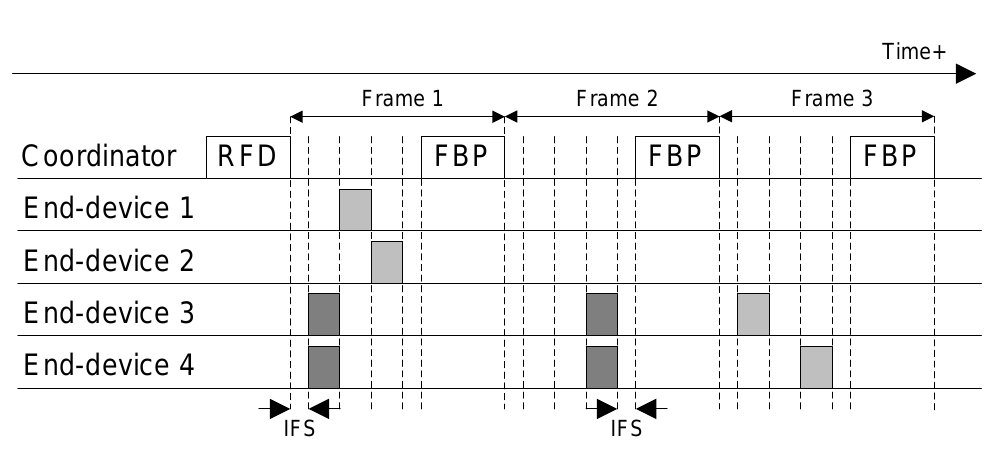
Figure 2. FSA-FBP operation example with four end-devices and three contention slots per frame.